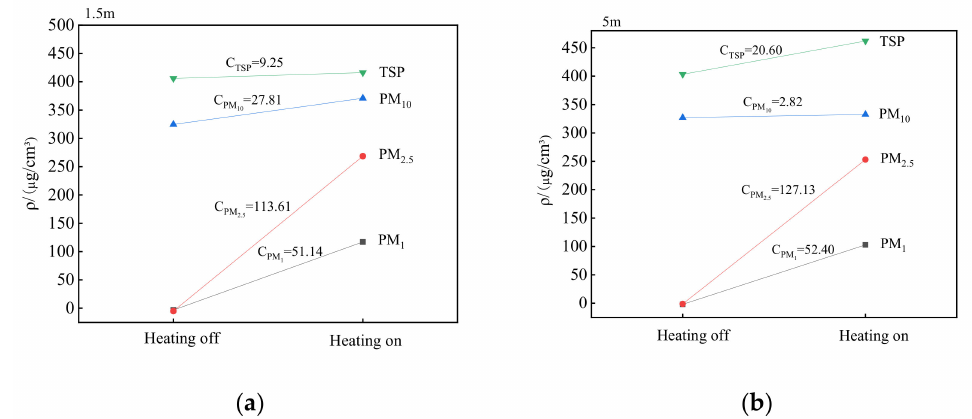
Figure 5. Changes in airborne particulate matter concentration before and after heating at different heights. Note: C represents the generalized linear analysis coefficient of the change in airborne particulate matter concentration before and after heating. The absolute value of C represents the difference between the factor level and the population mean. ( a ) Changes in airborne particulate matter concentration before and after heating at 1.5m height; ( b ) Changes in airborne particulate matter concentration before and after heating at 5m height.